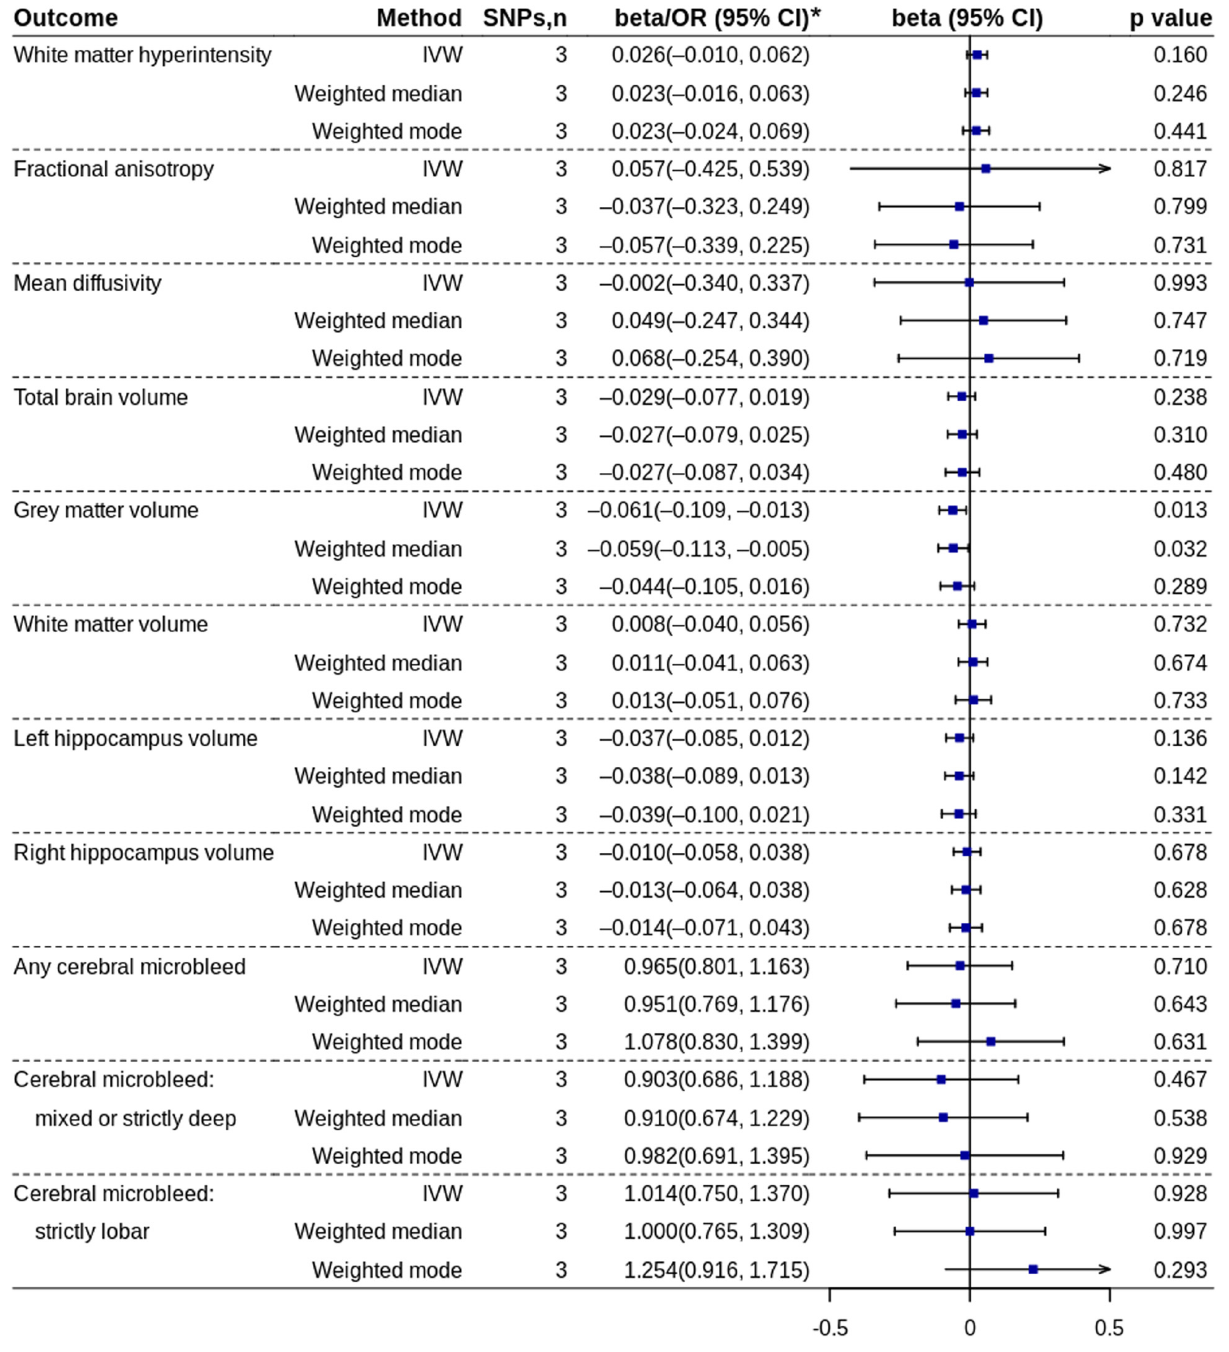
FIGURE 5 | Mendelian randomization analyses of high coffee consumption vs. low/no coffee consumption. IVW, inverse variance-weighted; OR, odds ratio; SNP, single nucleotide polymorphism. * ORs with 95% CIs are presented for cerebral microbleed